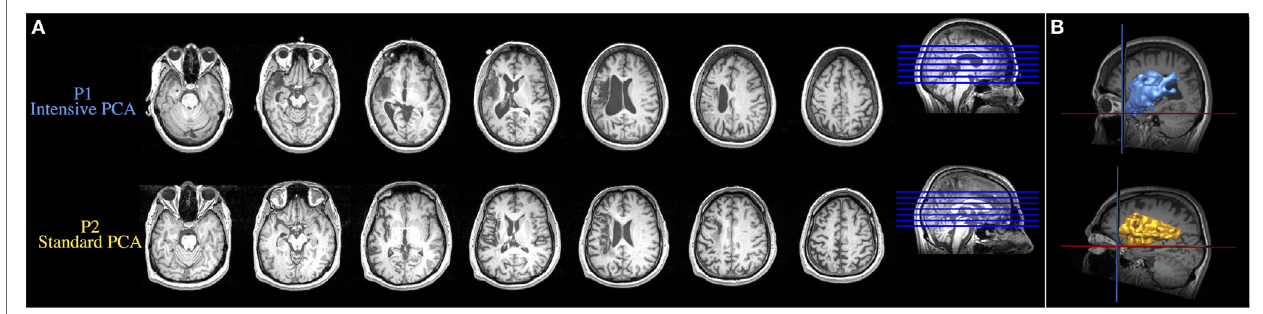
FIGURe 1 | (a) Axial MRI images showing the lesions resulting from a left ischemic stroke in the middle cerebral artery territory. (B) Reconstruction in 3D of the brain lesion of both patients. Upper and lower images are from the patient who received the intensive condition and the patient who received the standard regimen,